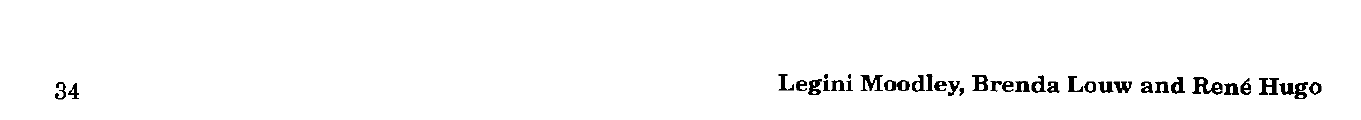
TABLE 6: Community nurses' specialized knowledge and attitudes regarding early communication intervention Community Nurses Roles in ECI